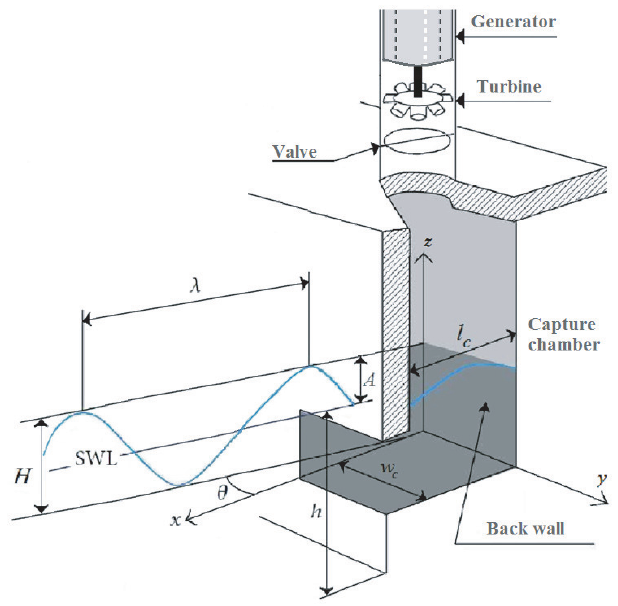
Figure 1. Sketch of an Oscillating Water Column (OWC) system and the sea wave